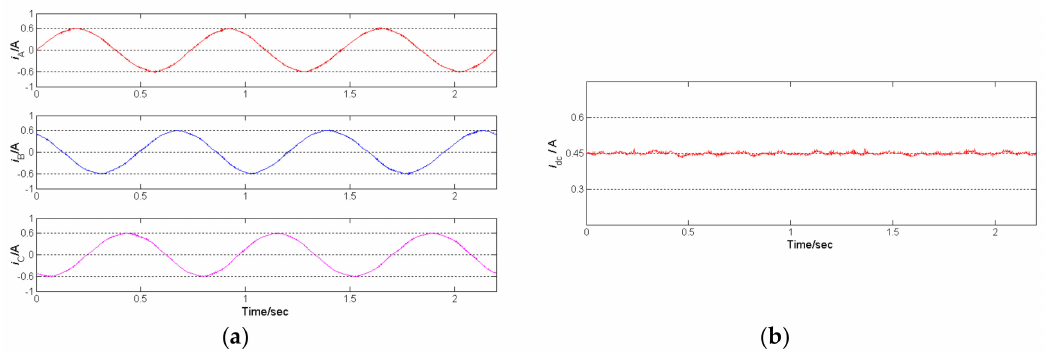
Figure 9. Current control results of proposed method. ( a ) Phase currents; ( b ) DC-link